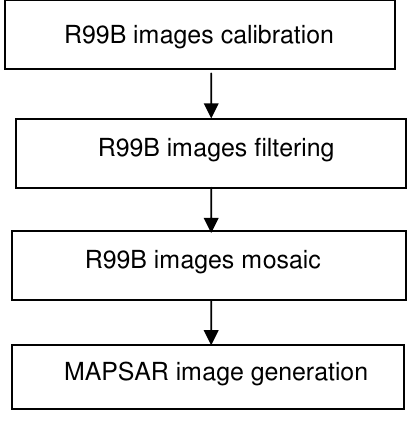
Figure 5. Processing flow to generate a simulated MAPSAR image